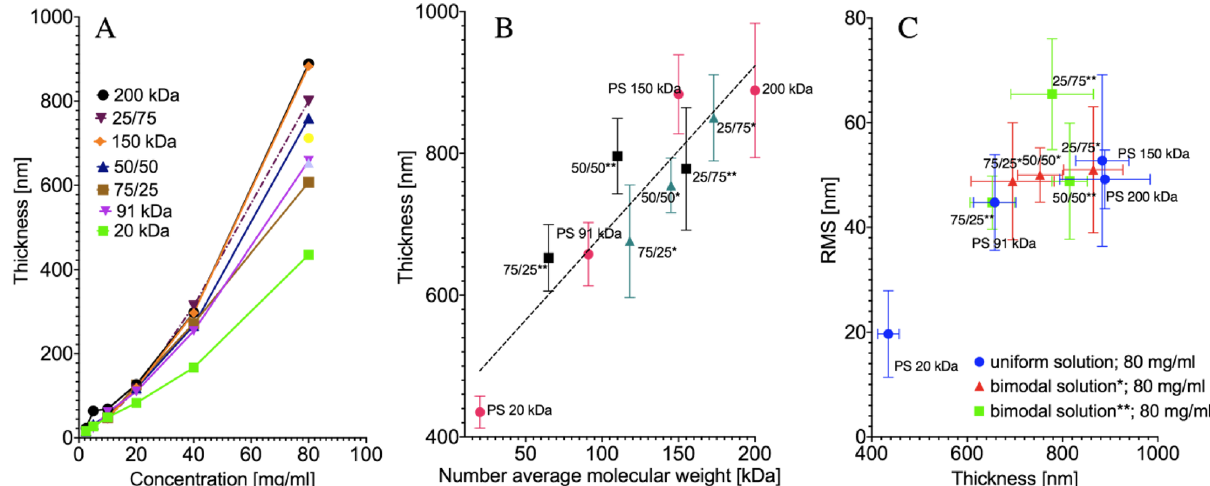
Figure 4. ( A ) Thickness of the coatings with respect to the composition and the concentration. The plot presents data for uniform and 91 kDa/200 kDa solutions. ( B ) Thickness of the coating for 80 mg/ml concentration in the blend’s molecular weight function. *Blends of 91 kDa and 200 kDa polystyrene; **blend of 20 kDa and 200 kDa polystyrene; x/x – w/w% ratio of blended homogeneous polystyrenes. The number average molecular weight [M n ] = f 1 M w1 + f 2 M w2 , where f w/w. % ratio of polymers. ( C ) RMS roughness of the coatings spun from 80 mg/ml